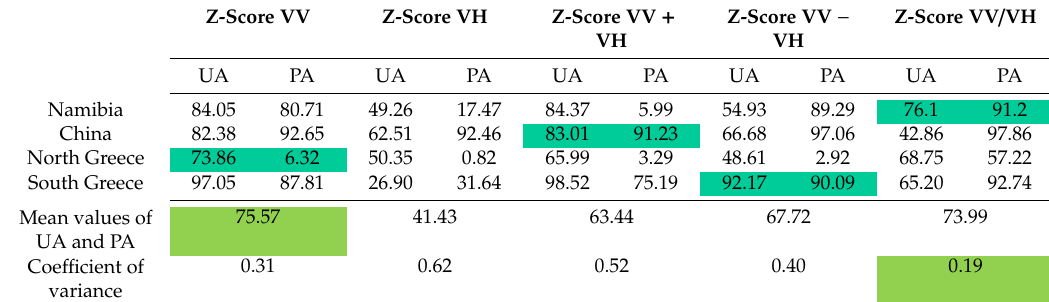
Table 8. The accuracy values PA and UA of the object-based classification for the individual study areas as a function of the five analyzed time series features. The relevant time series features for the individual study areas, which were identified by the Random Forest Algorithm (Section 3.1) and corresponding PA and UA values are highlighted in dark green. Optimum of statistical variables (mean value of UA / PA and coe ffi cient of variables) for time series features is highlighted in light